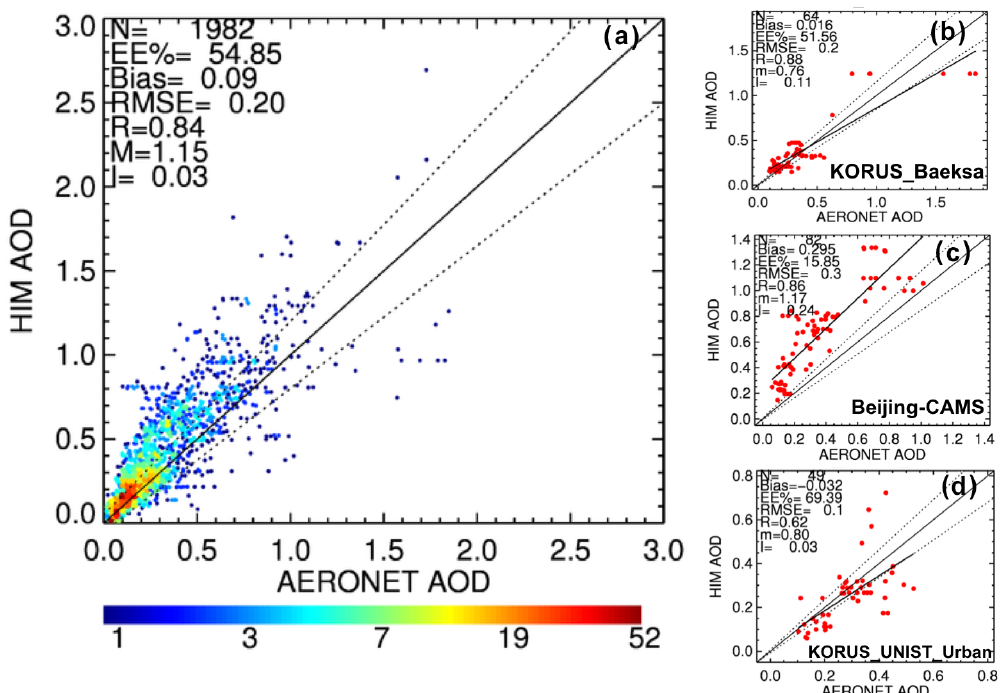
Figure 2. Density scatterplots of retrieved AOD at 550nm derived from AHI radiances using the new DT AHI algorithm versus AOD at 550nm spectrally interpolated from measured AODs from AERONET instruments collocated in time and space. (a) All accumulated col- locations in the AHI full-disk domain over the 2-month study period May–June 2016. Panels (b) , (c) , and (d) are the same for individual stations KORUS-Baeksa and KORUS-UNIST_Ulsan in Korea and Beijing CAMS in China. Shown in each panel are the number of colloca- tions ( N ), percent within expected error as determined from MODIS DT analysis (EE%), mean bias (Bias), root-mean-square error (RMSE), correlation coefficient ( R ), slope ( m ), and intercept ( I ) of a linear regression equation through the